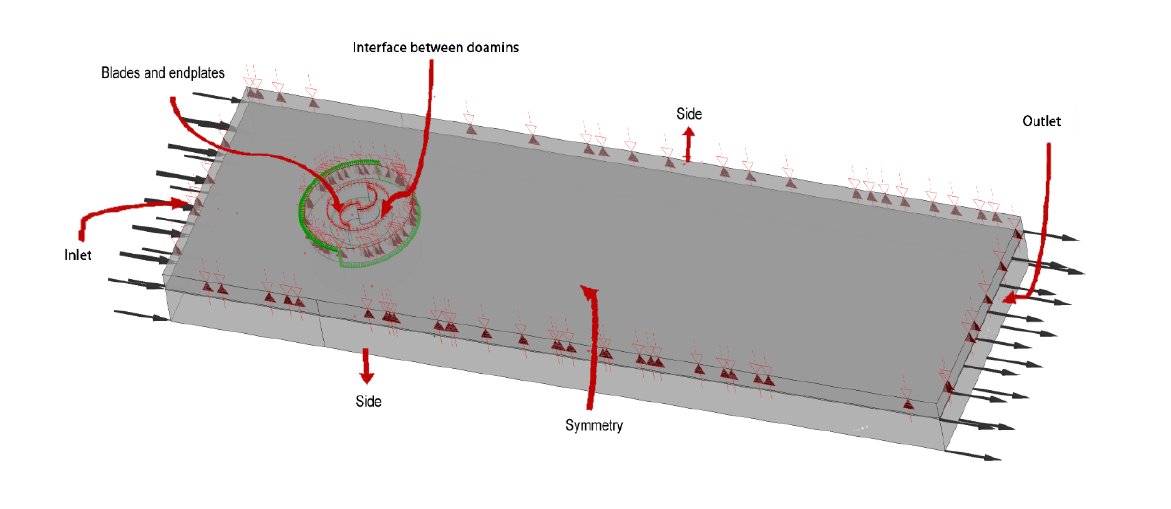
Figure 3: Orthogonal projection of 3D simulation